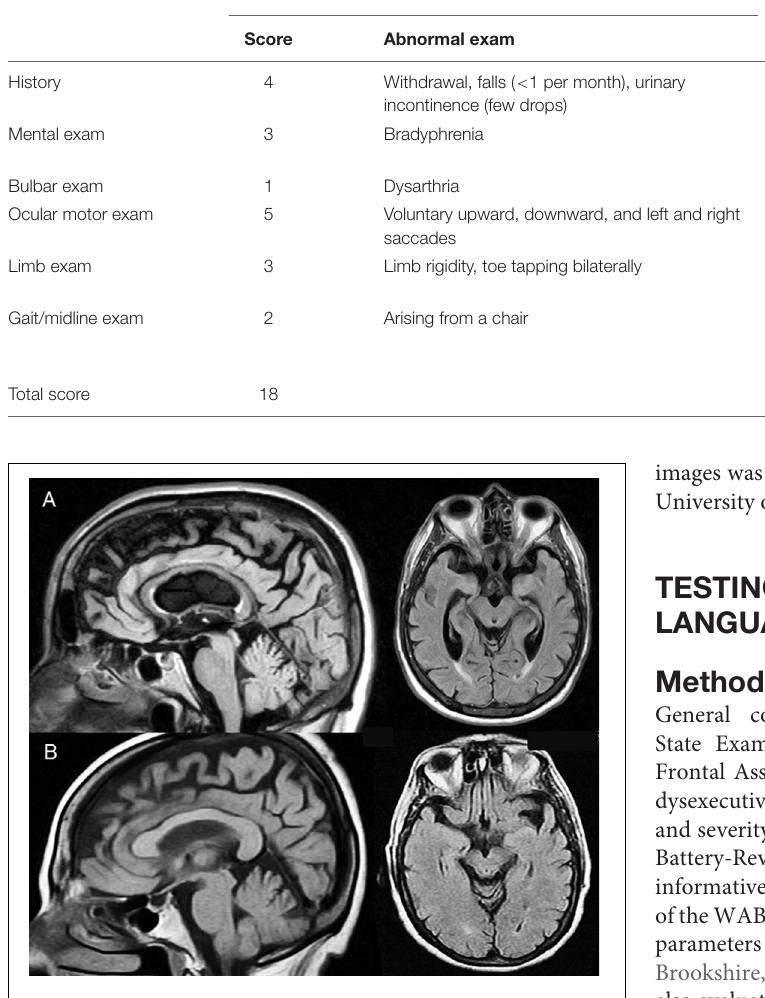
FIGURE 1 | Midsagittal (FLAIR sequences) slices show selective midbrain tegmentum atrophy with “Hummingbird sign” (flattening of the superior aspect of the midbrain tegmentum) in both patients. Axial slices (FLAIR sequences) additionally show a “Mickey Mouse sign” (reduction of the anteroposterior midline midbrain diameter) in patient 1 (A) and an incipient “Morning Glory sign” (loss of the lateral convex margin of the midbrain tegmentum) in patient 2 (B) , all of which are highly suggestive of PSP. Atrophy is also noted in the superior medial frontal cortex affecting the pre-supplementary motor area and the supplementary motor area, but the cingulate gyrus and the orbitofrontal cortex are preserved. Moderate atrophy of the body of the corpus callosum is seen in patient